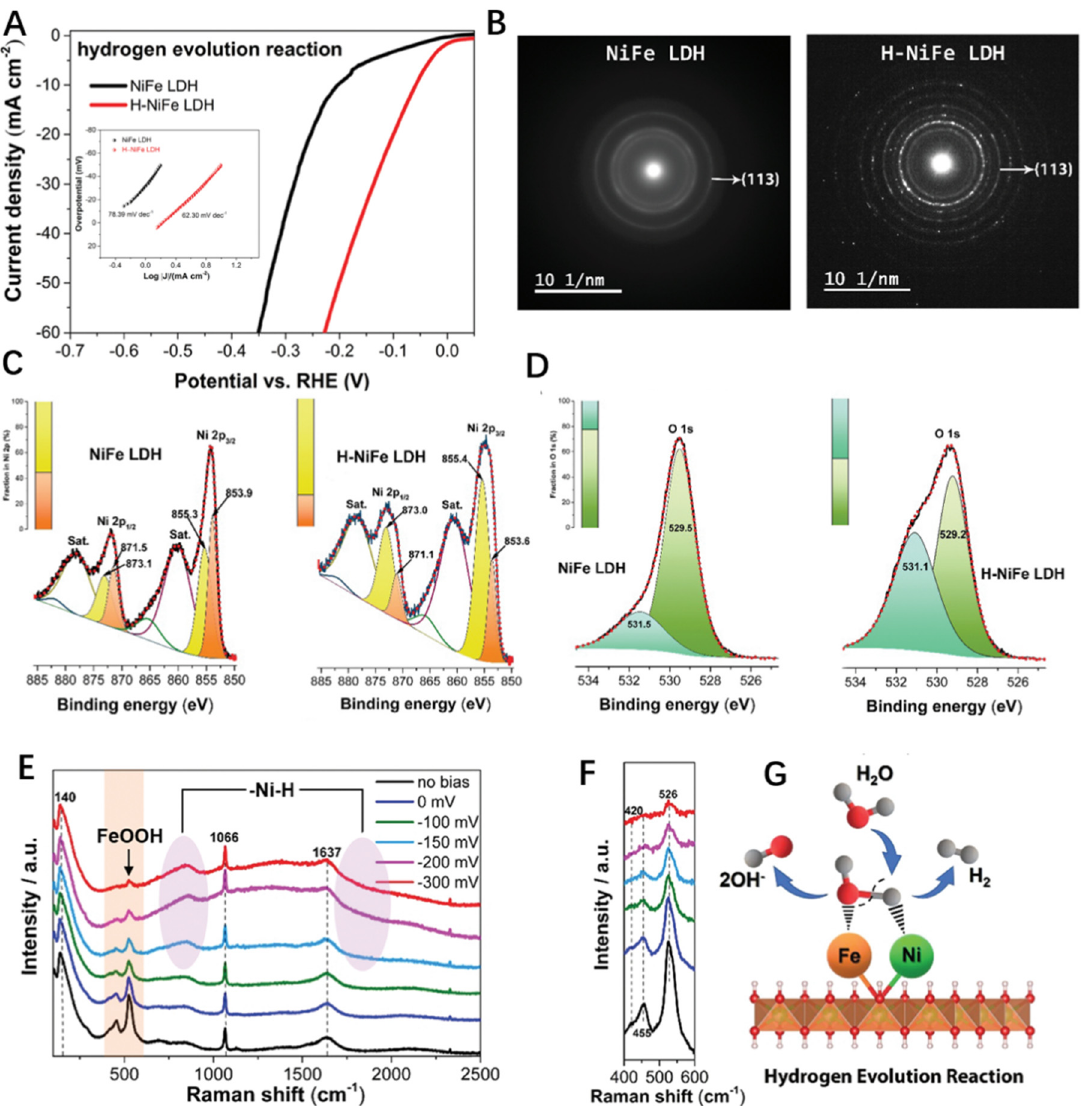
Figure 2. ( A ) Polarization curves obtained for pristine NiFe and H-NiFe LDHs in a three-electrode structure with a 1 M KOH aqueous electrolyte at a scan rate of 5 mV s − 1 . The inset plots are Tafel plots with 100% iR compensation for both at the abovementioned conditions. ( B ) SAED plots of NiFe and H-NiFe LDHs. High-resolution XPS patterns of Ni 2p ( C ) and O 1s ( D ) in NiFe and H-NiFe LDHs. ( E ) In situ Raman spectroscopy test results of NiFe LDH in the large wave number region during the HER in the 1 M KOH environment at different overpotentials. ( F ) The amplification of the orange region in ( E ). ( G ) Diagram of the reaction mechanism of NiFe LDH in the HER process. Reproduced with permission from [18], ©The Royal Society of Chemistry 2014.